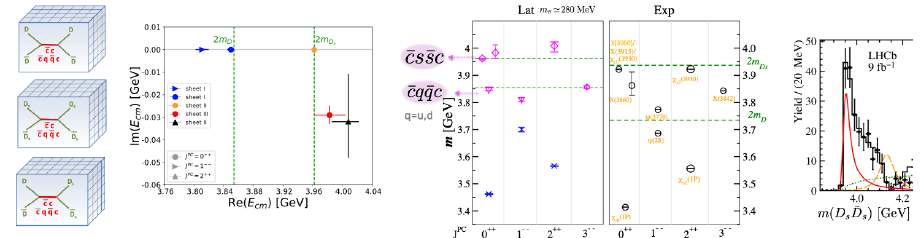
Figure 4. Charmonium system with I = 0: poles and masses from the lattice simulation of the scattering [13–15] and the LHCb discovery of a X (3960) [16] composed of ¯ cs ¯ sc which was predicted by the lattice simulation